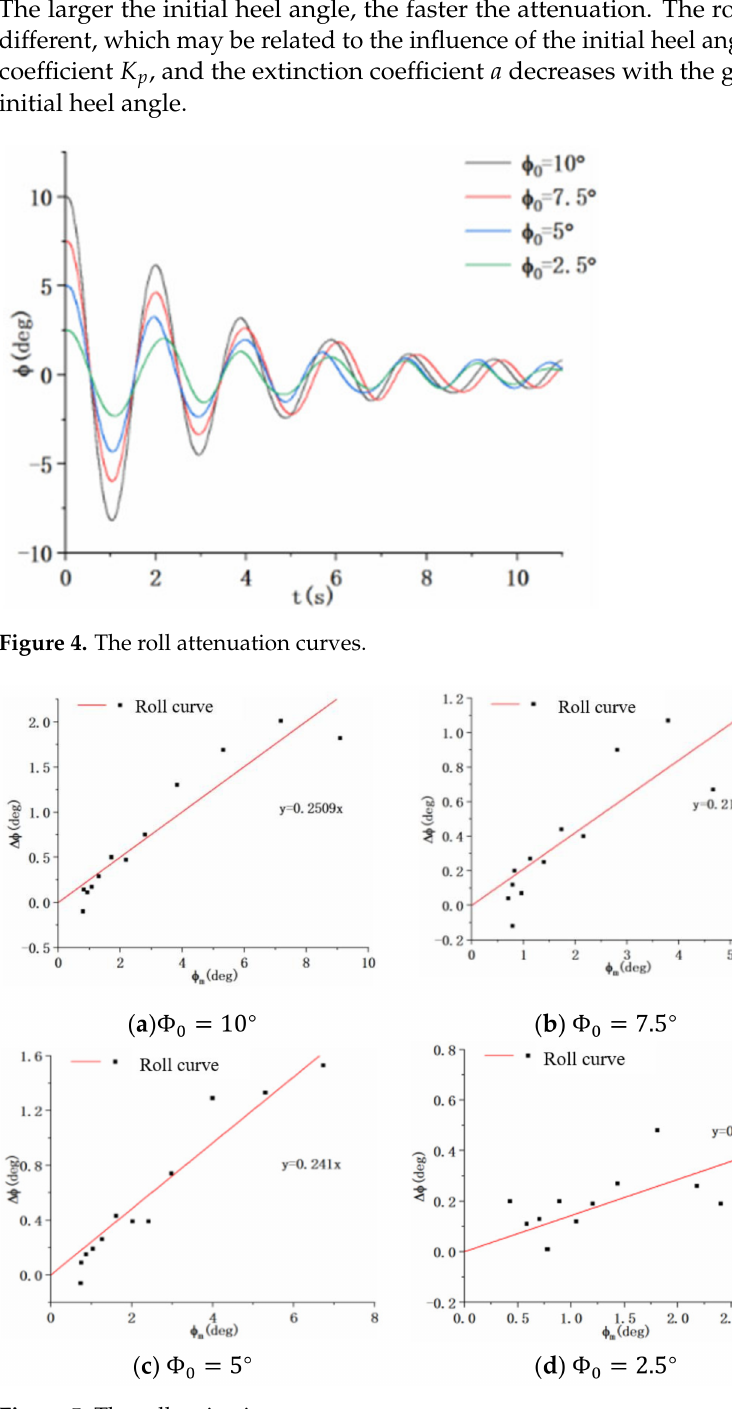
Figure 5. The roll extinction